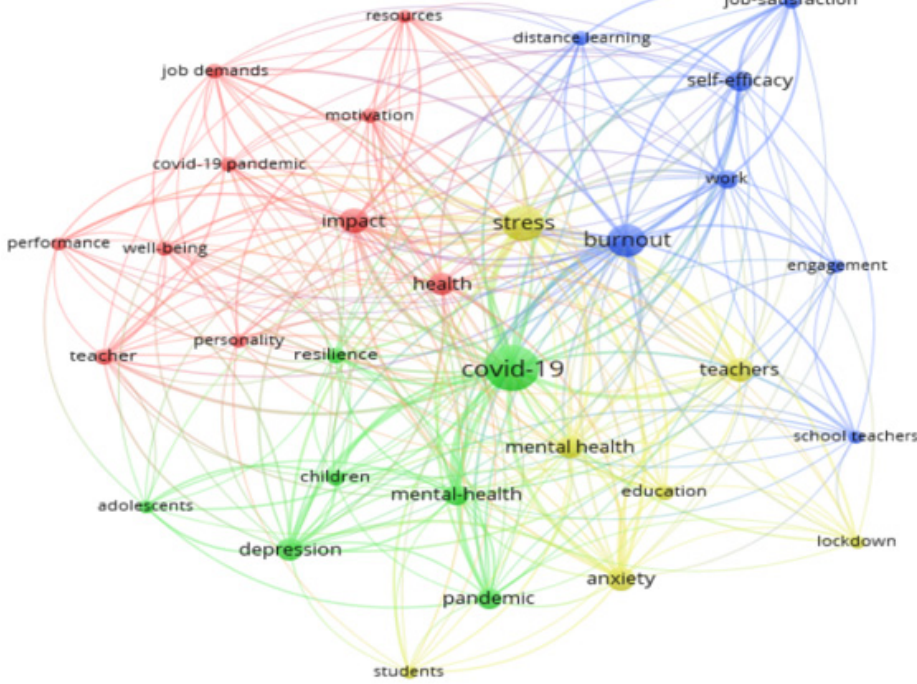
Figure 12. Bibliographic coupling analysis for co-word networks ( ≥ 5 co-word networks).